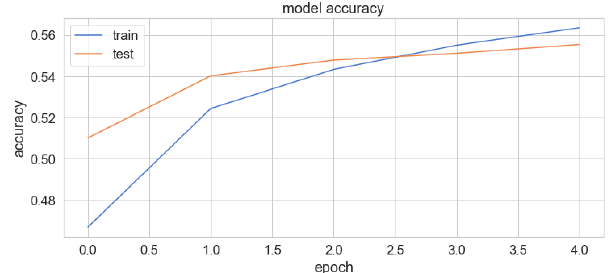
Figure 7. Accuracy on training and testing